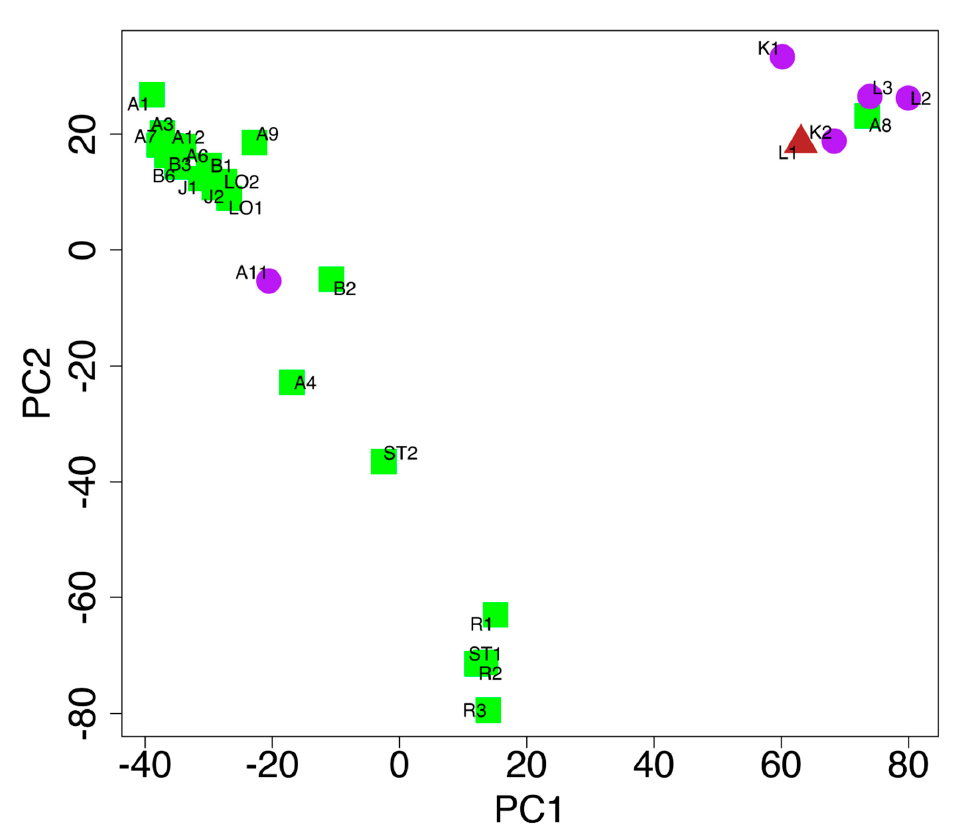
Figure 4. SNPs markers data: Accession-level principal component analysis (PCA) of the SNP markers, where the use of color refers to the leaf color of the cabbage accessions (purple circles = purple leaves, green squares = green leaves, reddish-brown triangles = purple / green leaves). PC1 and PC2 explain 15% and 10% of the total variation, respectively.